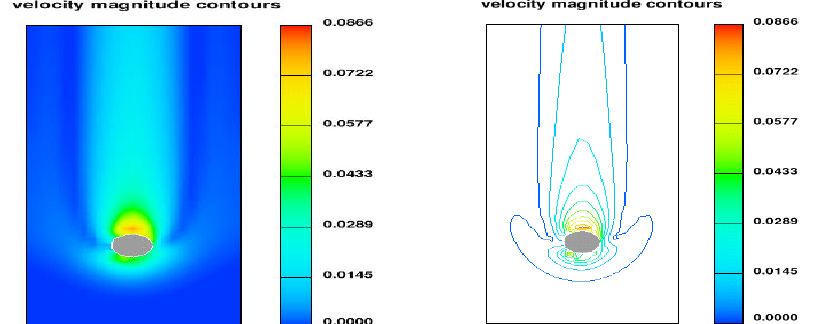
Fig. 1. Velocity magnitude contour in particle with diameter of 0.77